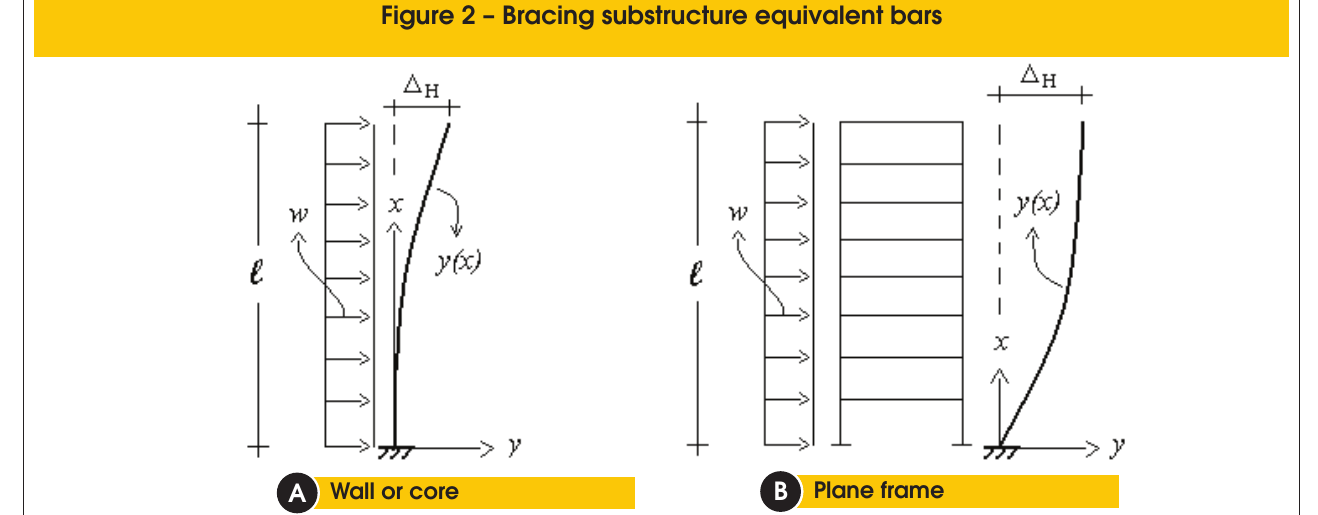
Figure 2 – Bracing substructure equivalent